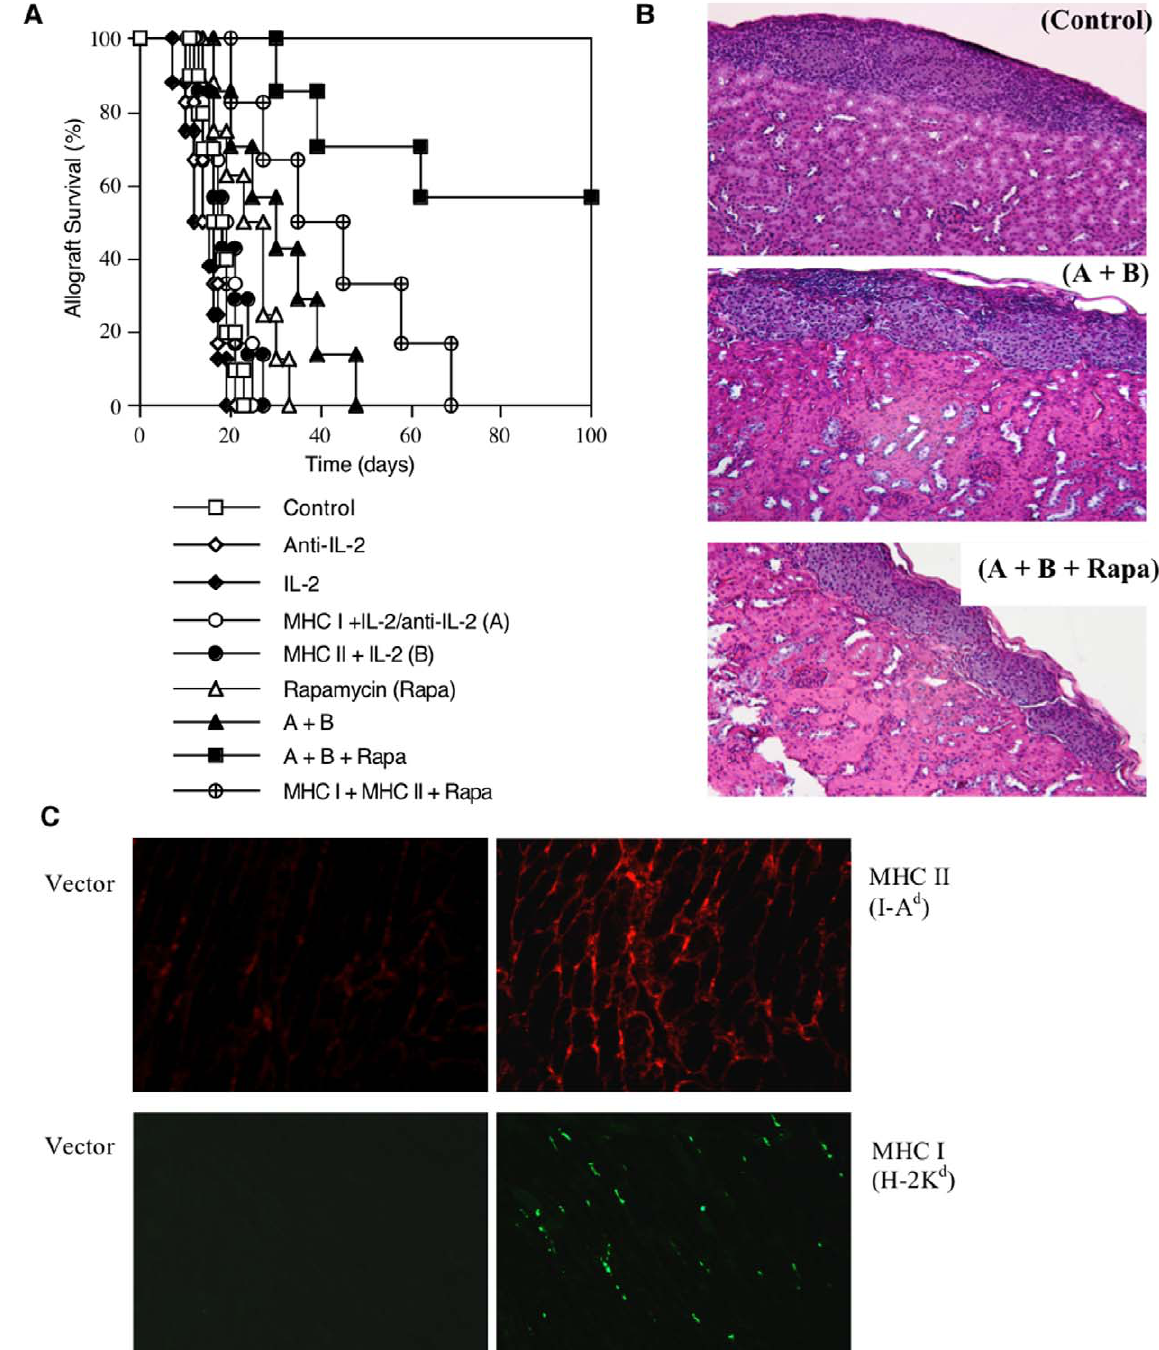
Figure 2. Donor MHC DNA vaccination and administration of IL-2 regimen prior to transplantation promote long-term islet allograft survival. Prior to transplantation, B6 mice were untreated ( % , n=10) or treated with neutralizing anti-IL-2 ( e , n=6) alone, recombinant IL-2 alone ( u , n=8), donor MHC class-I DNA vaccination plus both IL-2 and subsequent anti-IL-2 (MHC I + IL-2/anti-IL-2: A) ( # , n=6), donor MHC class- II DNA vaccination plus IL-2 (MHC II + IL-2: B) ( l , n=7), or both MHC I and MHC II vaccination plus IL-2 regimen (A + B) ( s , n=7). In some groups, rapamycin control mice (Rapa) ( , n=8) or mice treated with both MHC vaccinations and IL-2 regimen (A + B + Rapa) ( n , n=7) or both vaccinations without IL-2 (MHC I + MHC II + Rapa) ( › , n=6) received low doses of rapamycin post-transplantation. ( A ). Islet allograft rejection was observed. ( B ). H&E staining on kidney sections at the time of rejection or 100 days after transplantation. ( C ). Immunofluorescence staining on muscular frozen sections for the expression of donor MHC I (H-2K d ) or MHC II (I-A d ) three days after donor MHC DNA vaccination in a recipient. One representative of three independent experiments is shown.